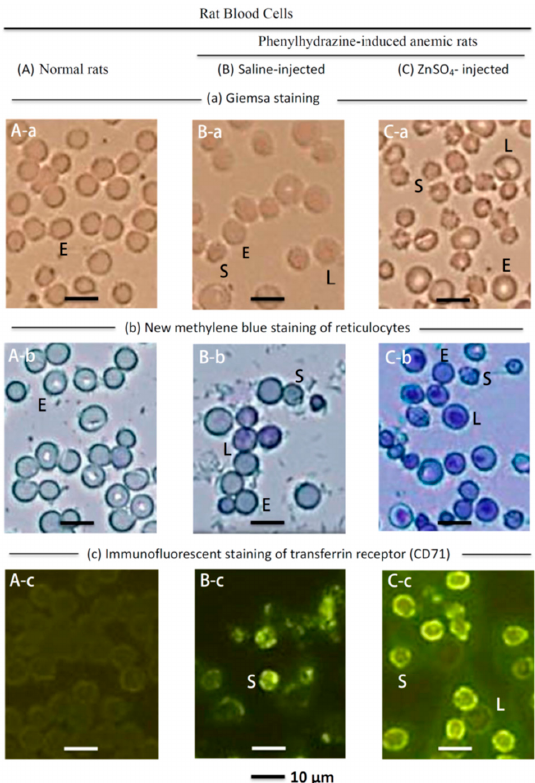
Figure 1. Induction of anemic rats by treatment with phenylhydrazine hydrochloride (PHZ) and the effects of ZnSO 4 on their RBC levels. ( A ) Normal rats were injected with saline or a single PHZ (60 mg/kg body weight) solution at day 0; ( B ) After two days, the PHZ-induced anemic rats were further injected with saline or different concentrations of ZnSO 4 solution. After another two days (at day 4), the rats were sacrificed, and RBC levels and other hematological indices were measured. *, significant difference between ZnSO 4 -injected and saline-injected anemic rats ( p < 0.05, n = 6). This figure is representative of three different experiments.